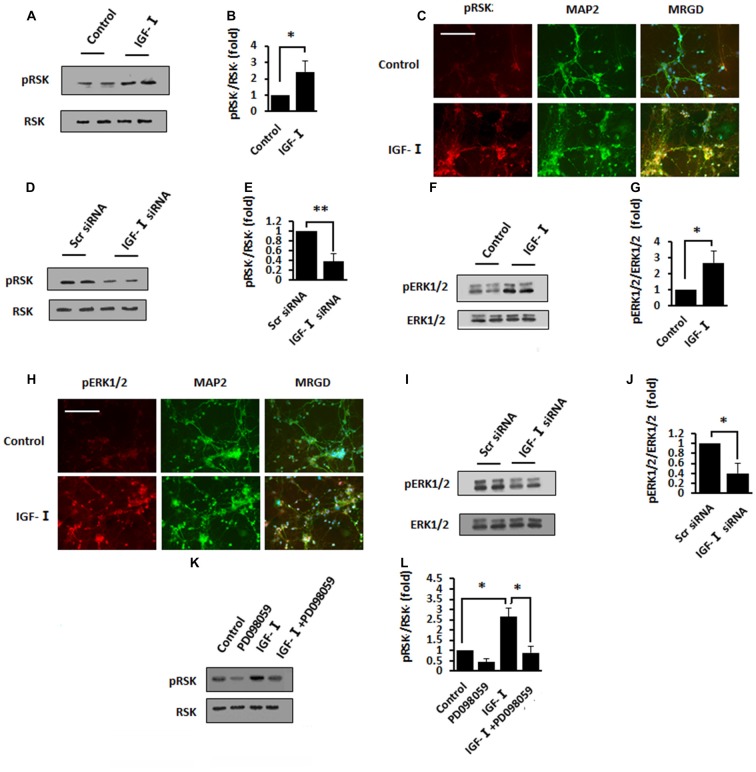
IGF-I potentiates activation of extracellular signal-regulated kinase 1/2/ribosomal S6 protein kinase (ERK1/2/RSK) signaling. (A,B) IB analysis of lysates of PHNs with IGF-I treatment using anti-pRSK and anti-RSK antibodies and subsequent densitometry. (C) Double IF staining of PHNs with IGF-I treatment using antibodies against pRSK (red) and MAP2 (green). (D,E) IB analysis of lysates of PHNs after IGF-I siRNA transfection using anti-pRSK antibodies and subsequent densitometry. (F,G) IB analysis of lysates of PHNs with IGF-I treatment using anti- pERK1/2 and anti-ERK1/2 antibodies and subsequent densitometry. (H) Double IF staining of PHNs with IGF-I treatment using antibodies against pERK1/2 (red) and MAP2 (green). (I,J) IB analysis of lysates of PHNs after IGF-I siRNA transfection using anti-pERK1/2 antibodies and subsequent densitometry. (K,L) IB analysis of lysates of PHNs with IGF-I treatment in the absence or presence of PD098059 using anti-pRSK and anti-RSK antibodies and subsequent densitometry. Data are shown as mean ± SD. *P < 0.05, **P < 0.01. Scr, scramble. Scale bar, 25 mm. MRGD, merged image.